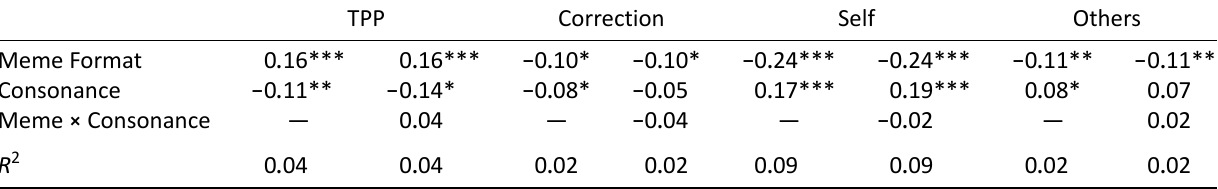
Table 1. Effects of media format and consonance on perceptions of influence and correction. TPP